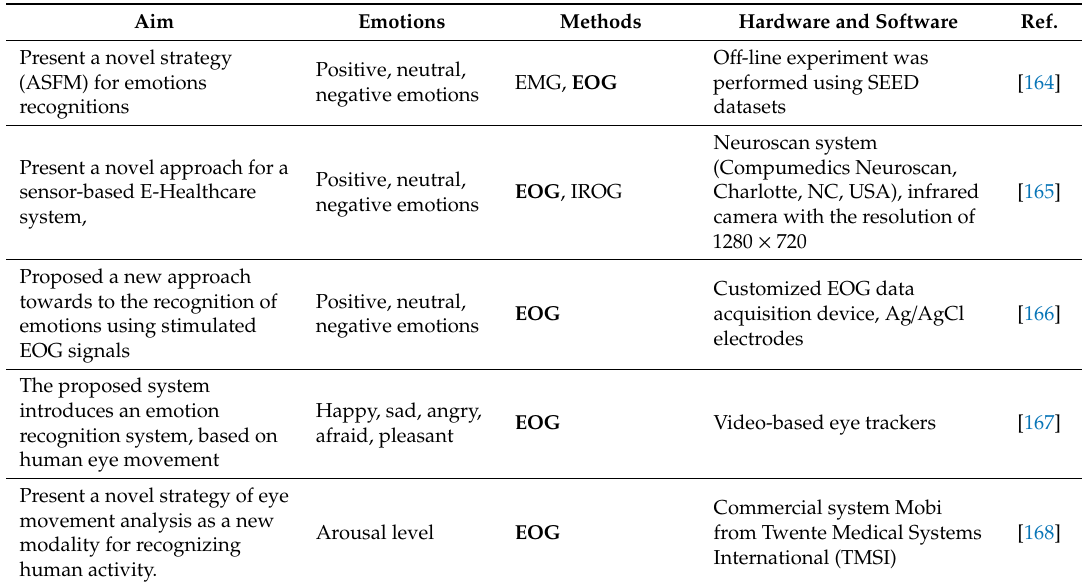
Table 11. Review of scientific researches focused on emotions recognition and evaluation using EOG. Aim Hardware and Software